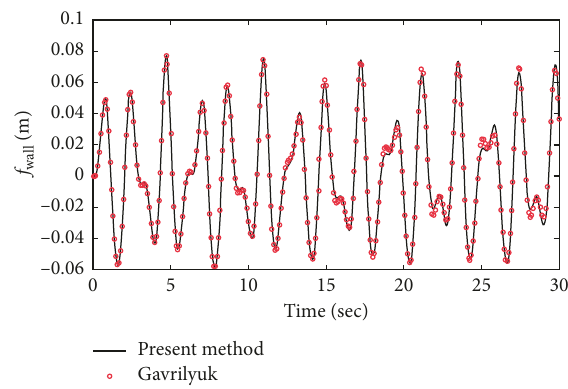
Figure 6: Time history of the surface wave height on the wall at θ � 0 for ω � 4 rad/s.